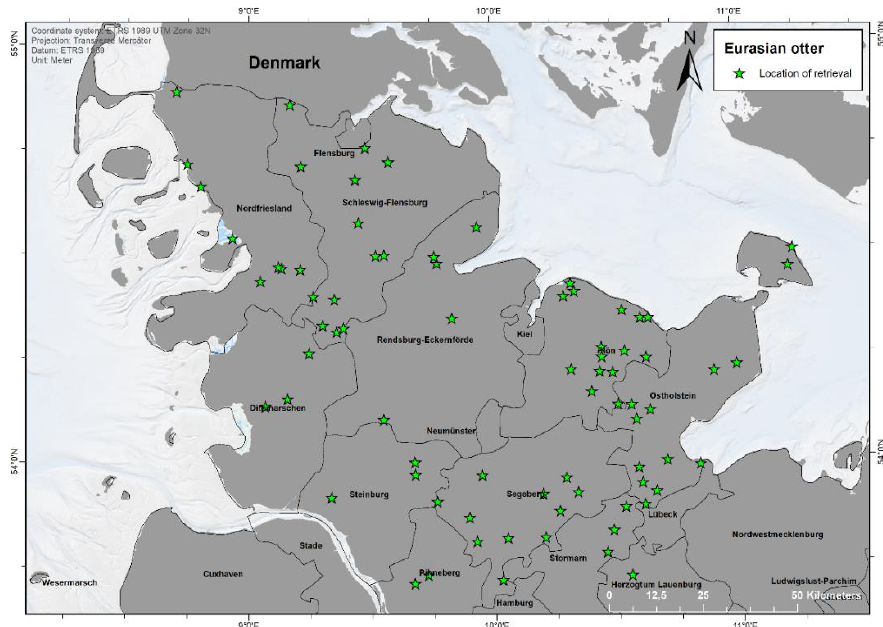
Figure 1. Finding locations of 85 otters found dead between 2015 and 2020 in Schleswig-Holstein, Germany. Map made with ArcGIS for Desktop 10.5 (© ESRI, Inc., Redlands, CA,